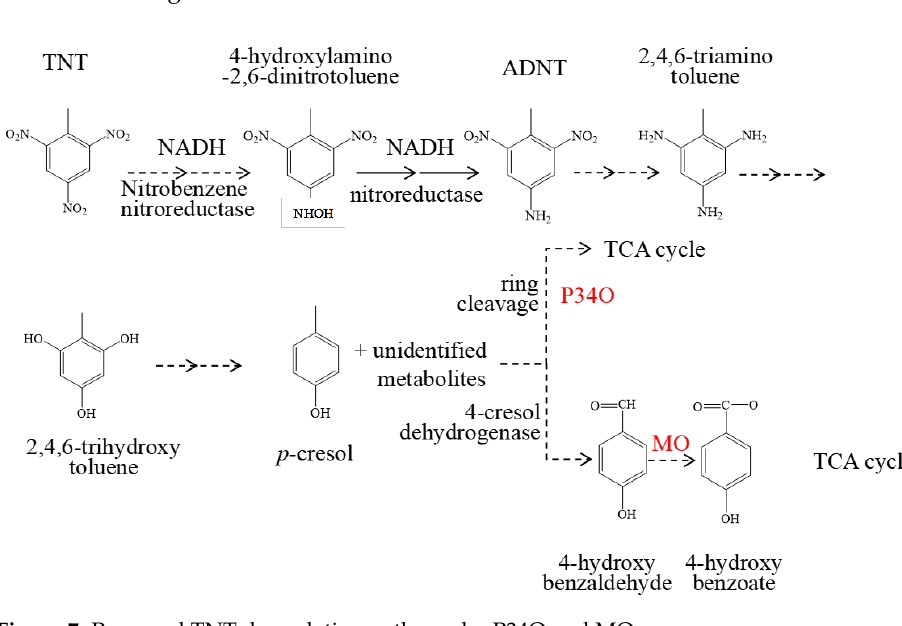
Figure 7. Proposed TNT degradation pathway by P34O and MO.